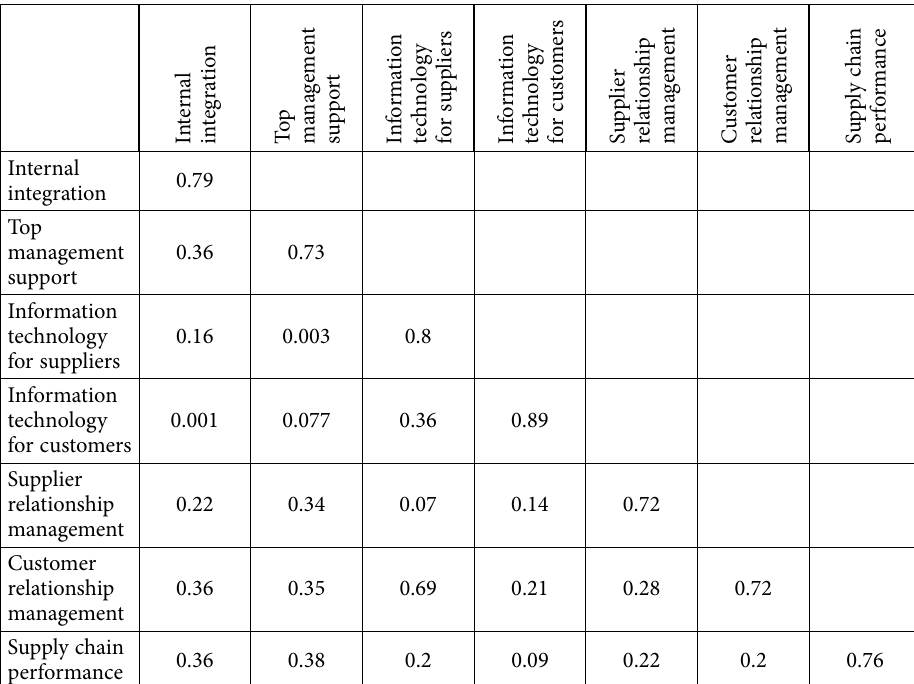
Table 3. Fornell and Larcker